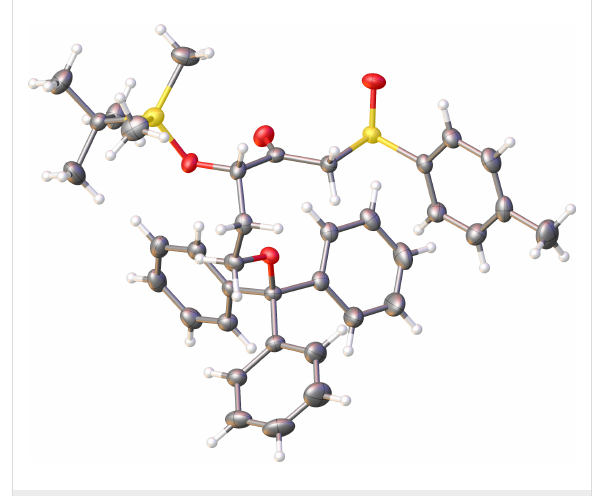
Figure 2: Crystal structure of compound 9